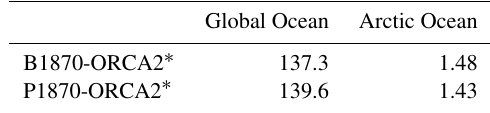
Table A1. C ant inventories in 2012 in Pg